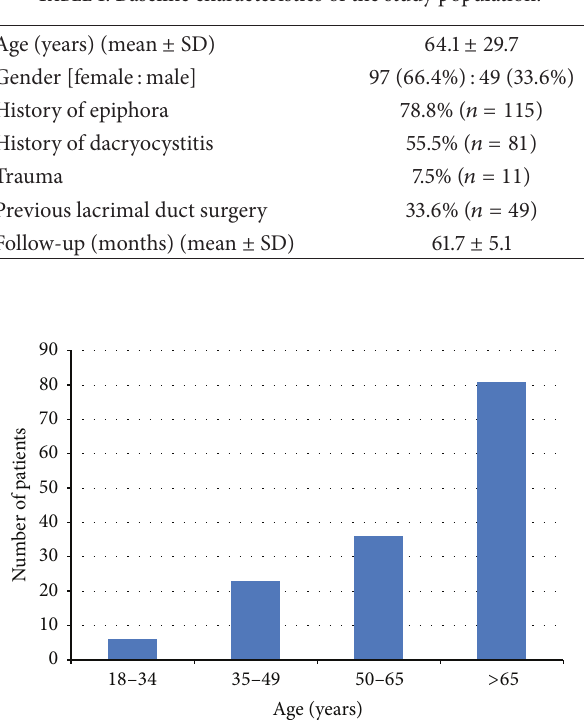
Figure 1: Patient age.